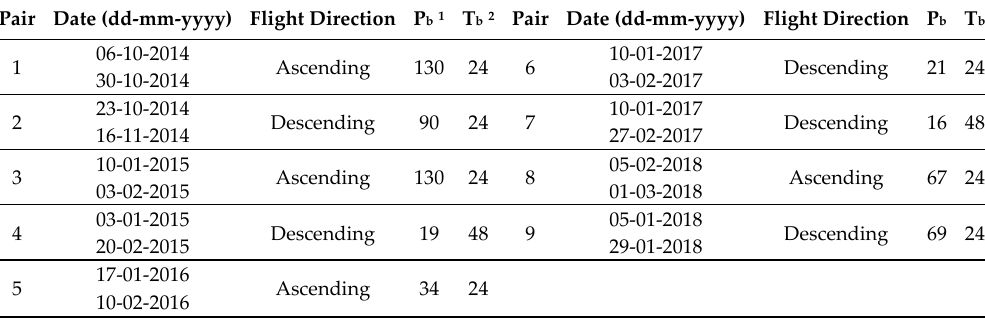
Table 1. Characteristics of interferometric pairs